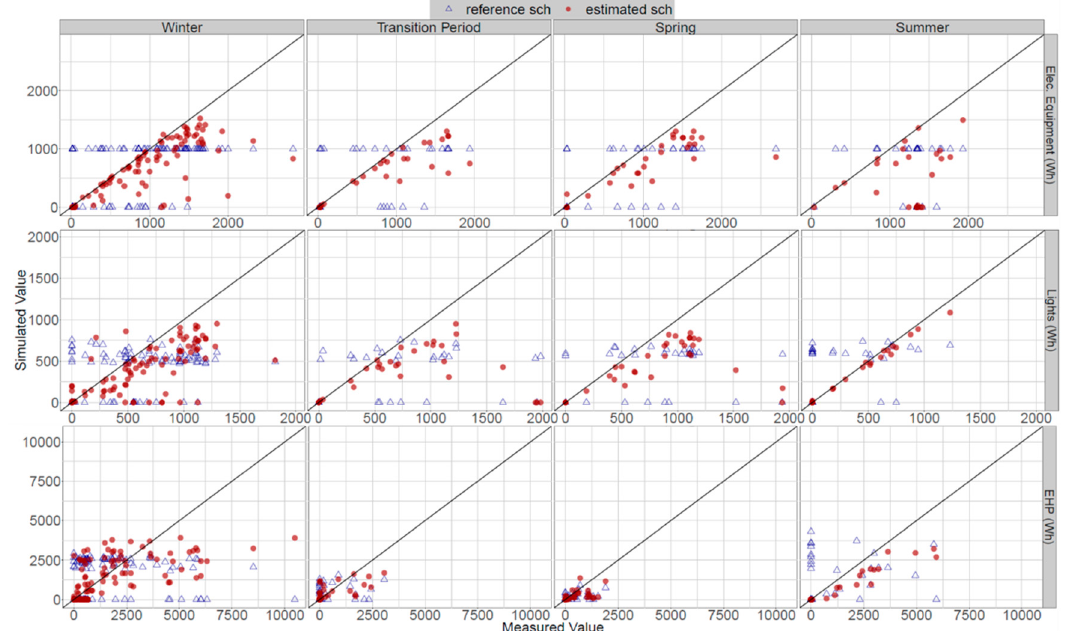
Figure 12. Scatter plot of electricity consumption with the reference and estimated schedules with respect to season and device. Table 12. Margin of errors in energy consumption estimation results using the reference and Assumed